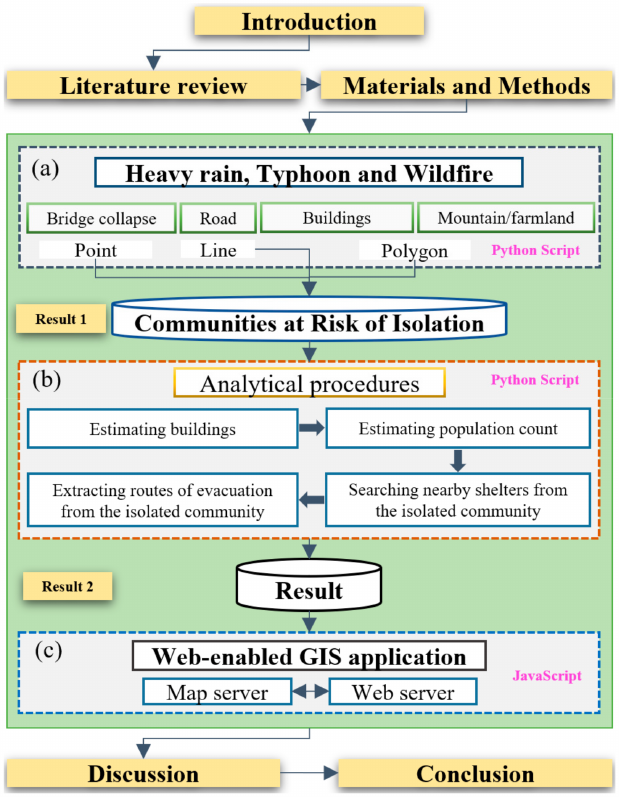
Figure 2. Workflow of this research: ( a ) first module: Data collection and working scenarios, ( b ) sec- ond module: Analytical procedures, ( c ) third module: Deployment of web-enabled GIS